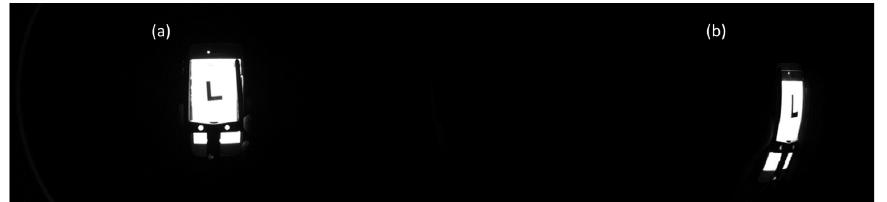
Figure 8. Image of the slanted edge evaluating the image quality of the visible and NIR camera channels: ( a ) on-axis positioning, ( b ) off-axis positioning (at 179°), indicating the presence of barrel distortion.